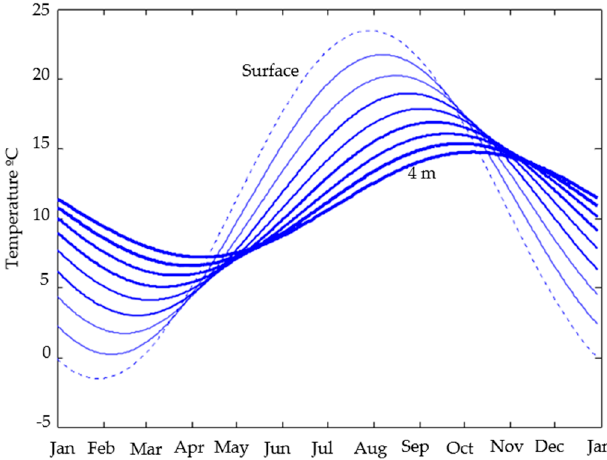
Figure 3. Typical temperature behavior of the soil close to the surface at different depths. The curves show the evolution of the temperature from the surface (0 m) to 4 m depth in steps of 0.5 m.